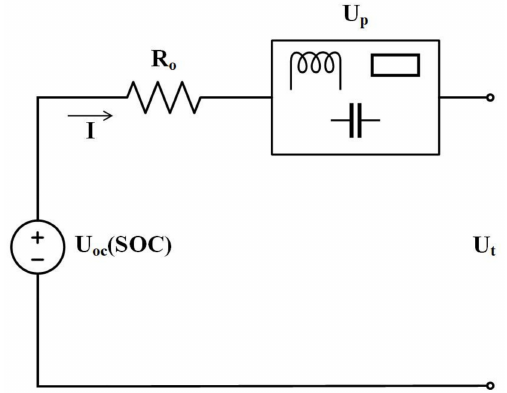
Figure 13. Linear regression model